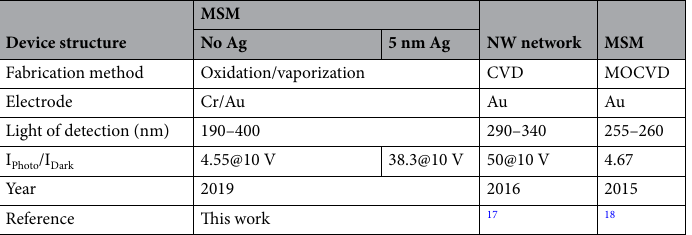
Table 2. Summary of β-Ga 2 O 3 device performance of present device and other previously reported UV PDs.